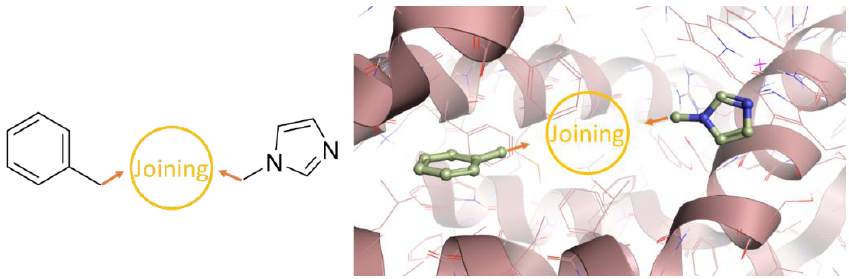
Figure 2. Representation of the ligand-joining experiments inside HO-1.